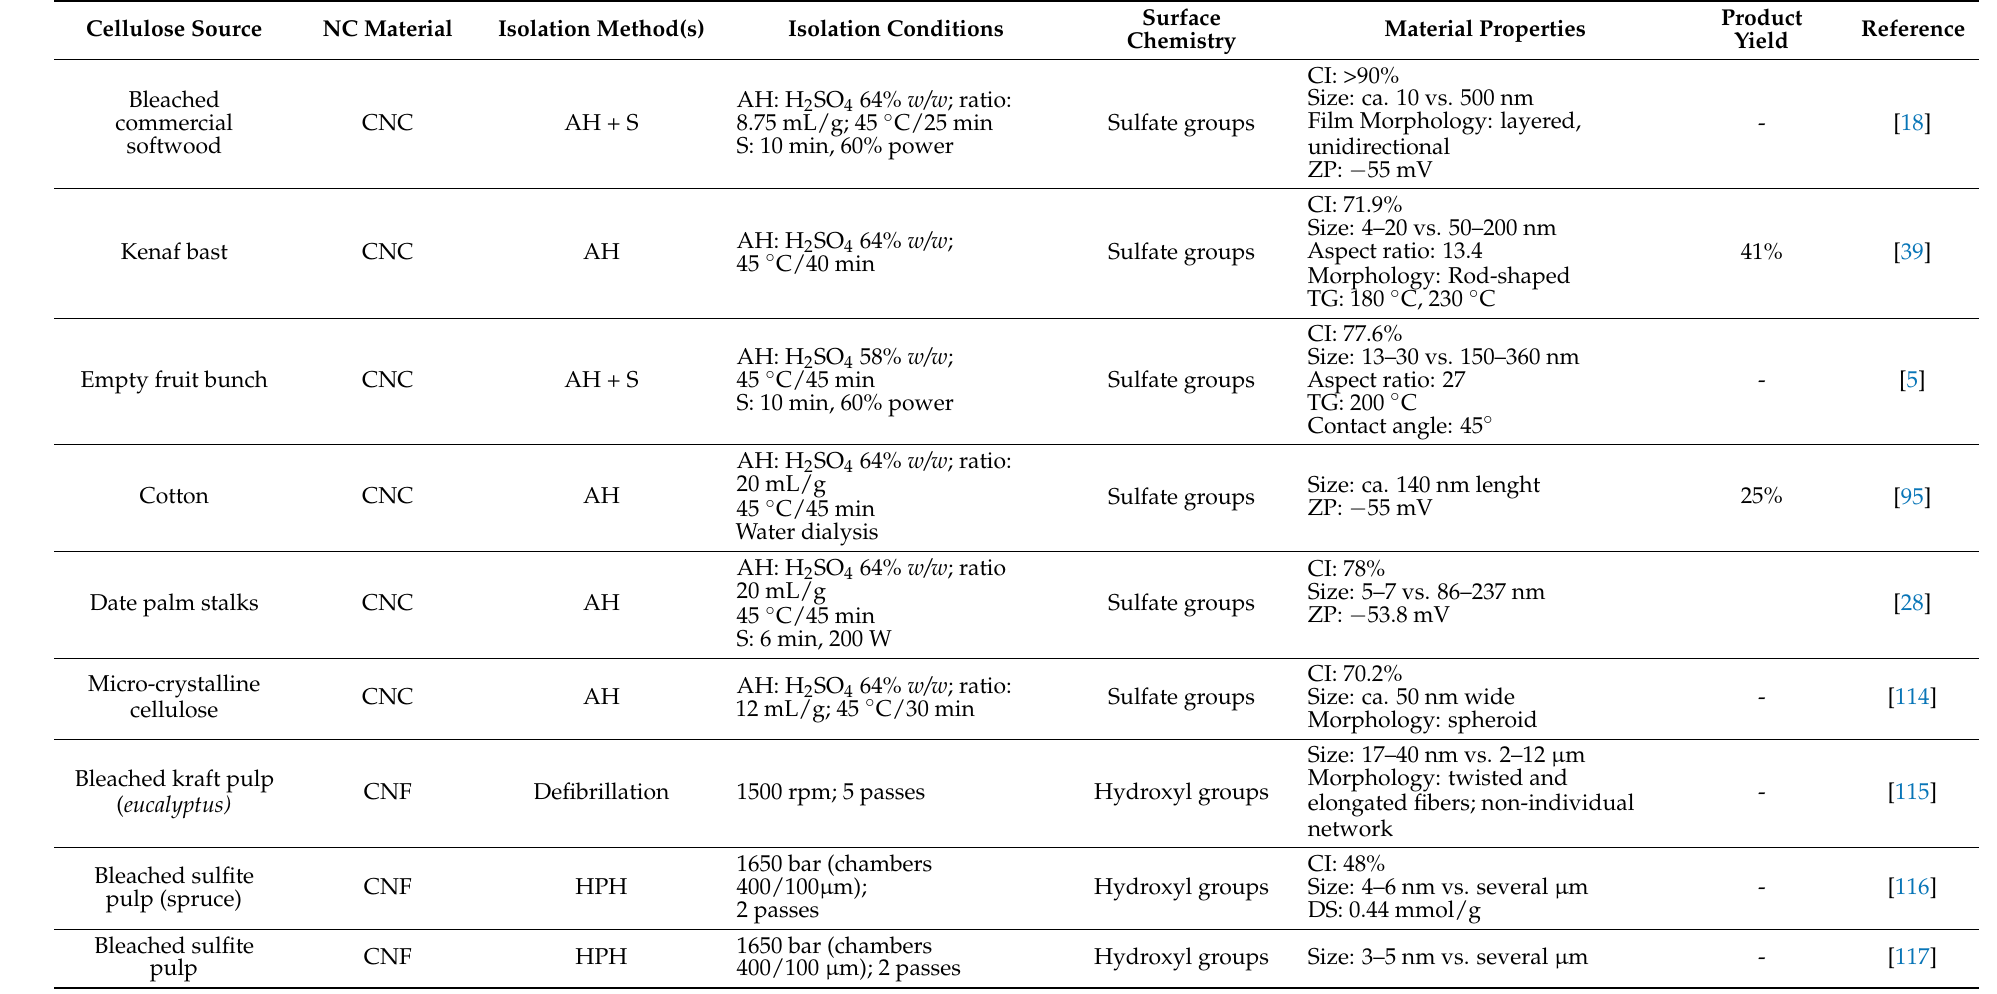
Table 1. Isolation methods and material properties of NC to be applied as carrier in the delivery of liposoluble